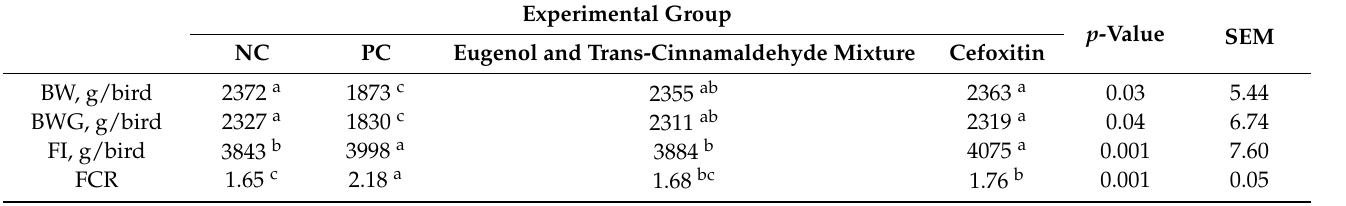
Table 7. Effects of supplementing the mixture of eugenol and trans-cinnamaldehyde and cefoxitin treatment on the growth performance variables of the C. jejuni -challenged broilers over a 37-day experimental period.